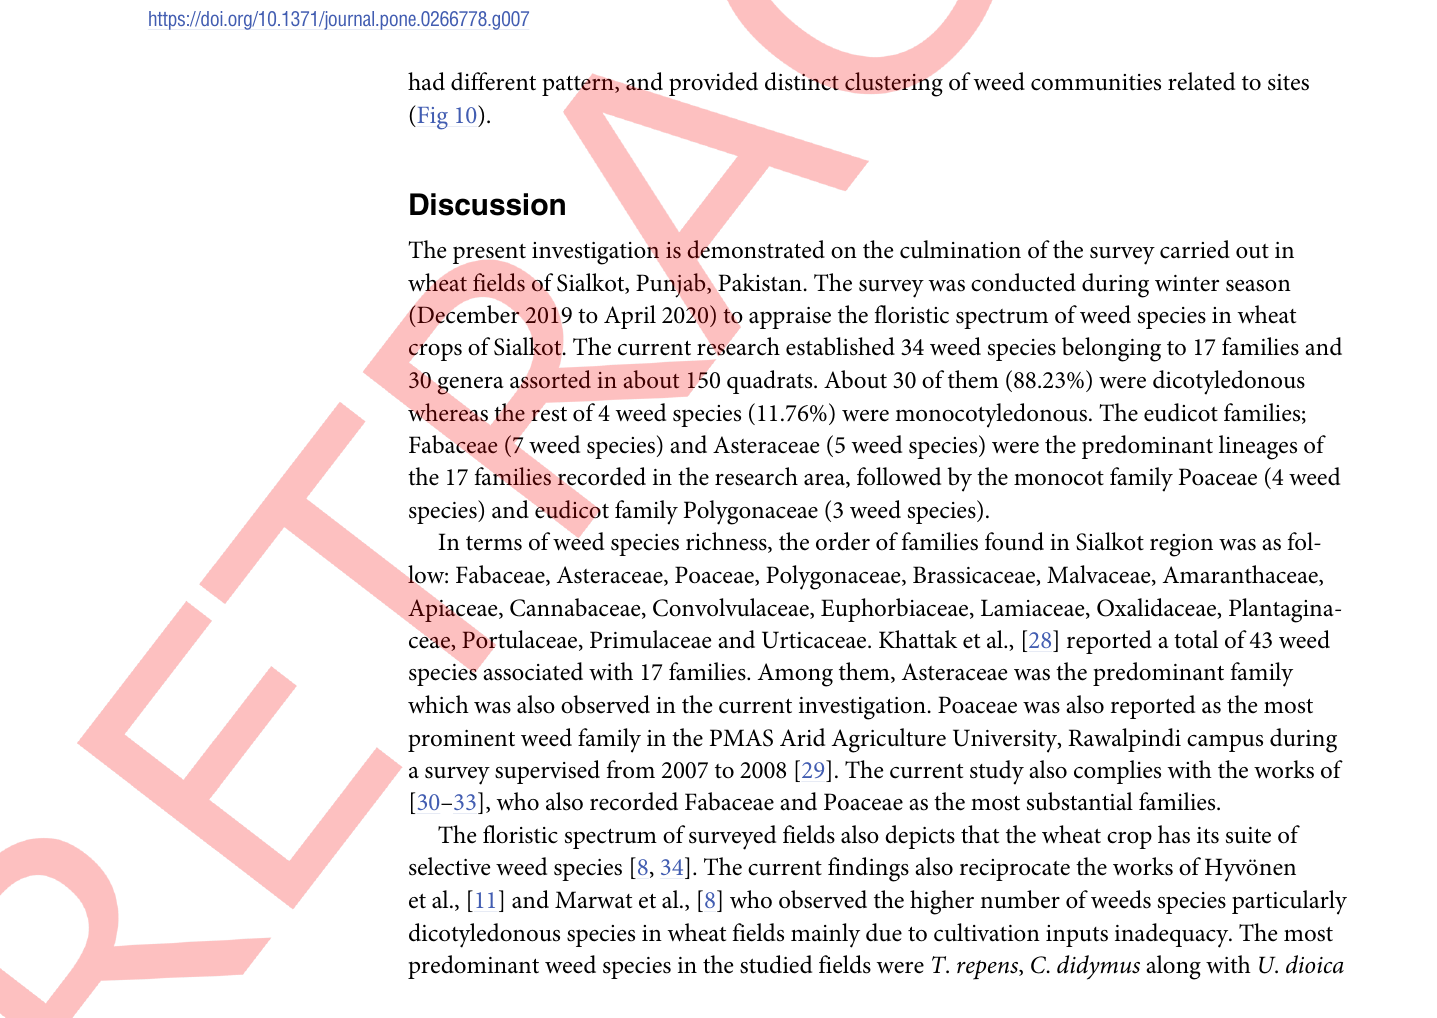
Fig 7. Correlation data on weed species and different edaphic factors. Abbreviations used are TDS (total dissolved solids); OM (organic matter); EC (electrical conductivity). � denotes significant interaction at p � 0.05, and �� denotes significant interaction at p � 0.01.